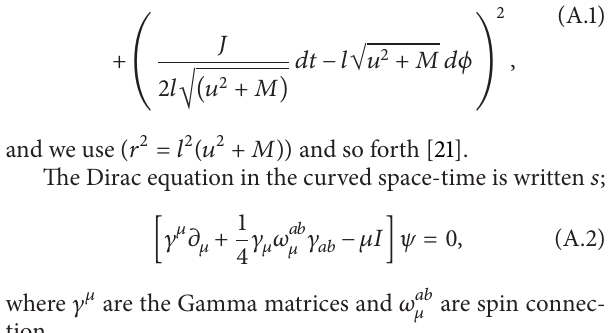
Figure 3: The entanglement entropy of fermion field for massive fields of a function of 𝑟 + /𝑎 with different masses (0.1, 0.3, and 0.5).